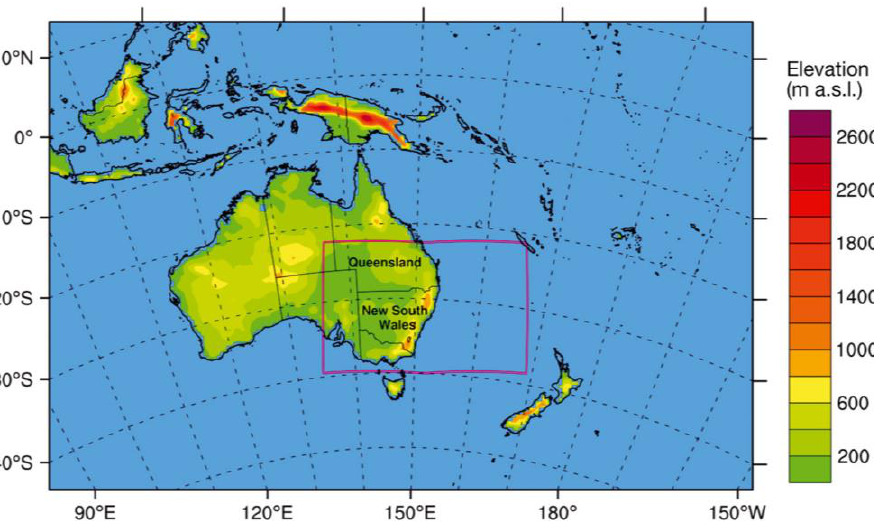
Figure 1. Weather Research and Forecasting (WRF) model domains with grid spacing of about 50 km (outer CORDEX domain shown as map extent) and 10 km (inner NARCliM domain shown with red outline). The topography (unit: m) is shown as shaded contours. The state and territory boundaries of Australia are included, which are also available in the other figures.